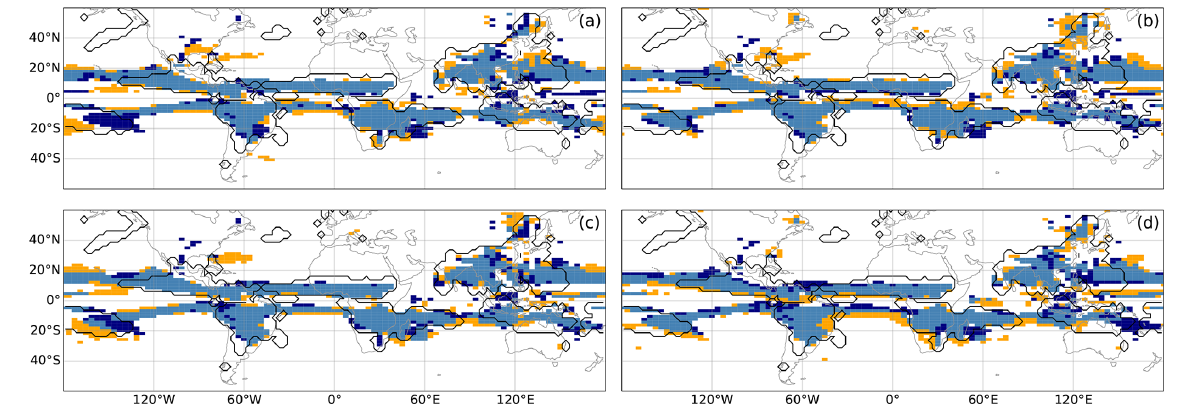
Figure 6. Observed (black contour) and simulated (shading) global monsoon regions based on the criterion by Lee and Wang (2014) for (a) RCP8.5, (b) WAIS3m, (c) GrIS1m and (d) GrIS3m. Orange (dark blue) shading depicts monsoon regions simulated for the historical (future) period. Light blue shading shows the monsoon domains that spatially intersect for both periods.